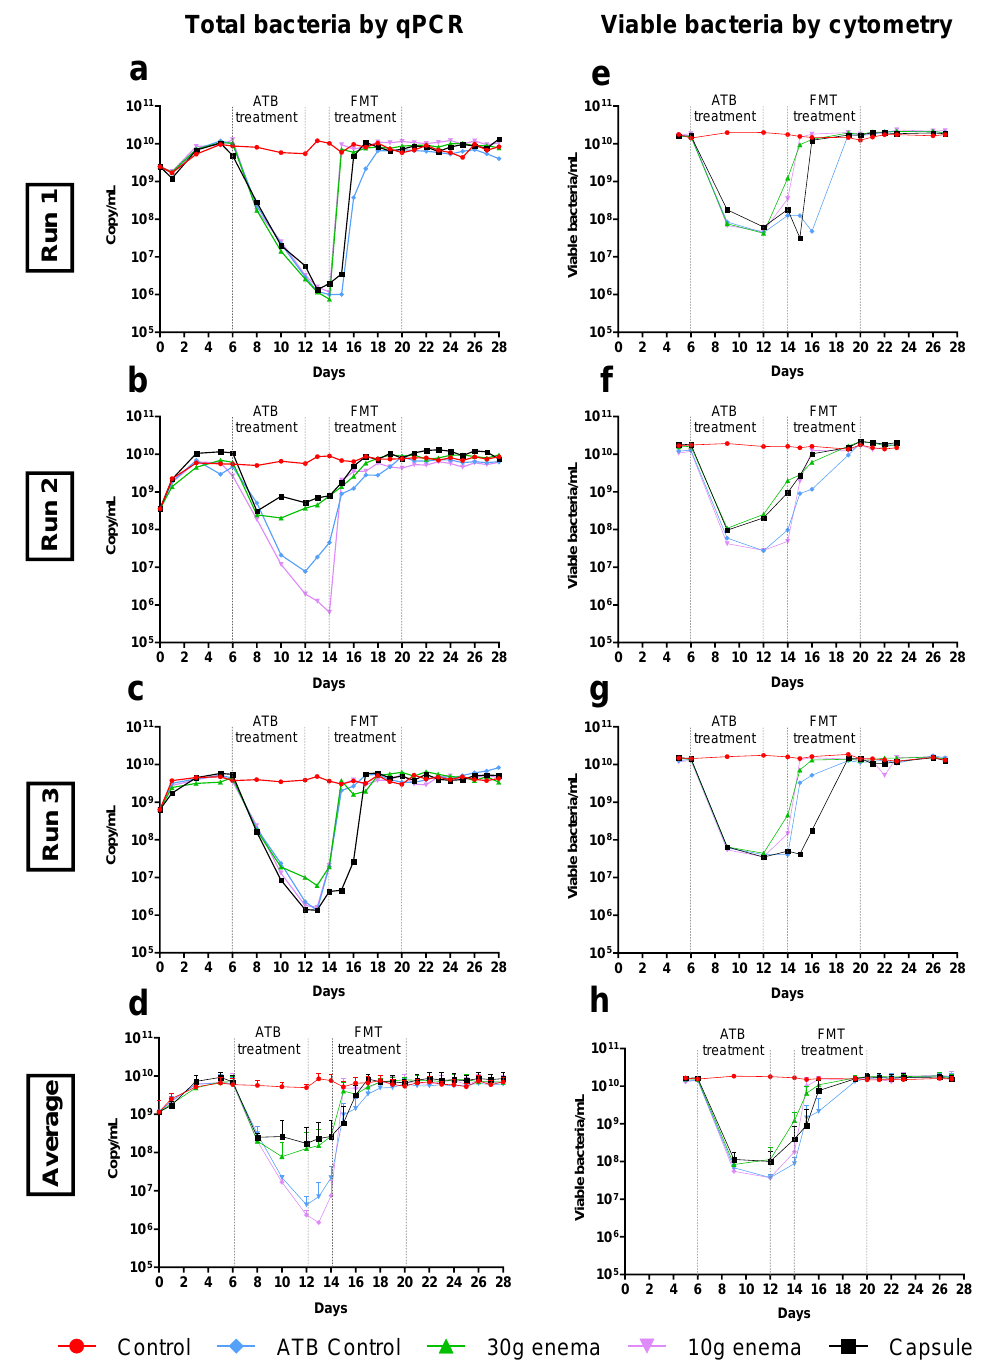
Figure 3. Effect of fecal microbiota transplantation (FMT) treatment on total bacteria. Experiments were performed as described in Figure 1 in triplicate with fecal samples from three healthy adult donors (Run1, Run2 and Run3). Different conditions were applied: no treatment (control, red), ciprofloxacin (ATB control, blue), ciprofloxacin and 30 g enema (green), ciprofloxacin and 10 g enema (purple), and ciprofloxacin with oral capsules (black). Total bacteria was determined by qPCR analysis and expressed as numbers of 16S rRNA gene copies/mL in Run1 to Run3 (subfigures a to c ) or in mean number of copies/mL ± SEM (subfigure d , n = 3). Total viable bacteria was determined by flow cytometry through a live/dead analysis and expressed as number of viable cells/mL in Run1 to Run3 (subfigures e to g ) or in mean viable cells/mL ± SEM (subfigure h , n = 3).